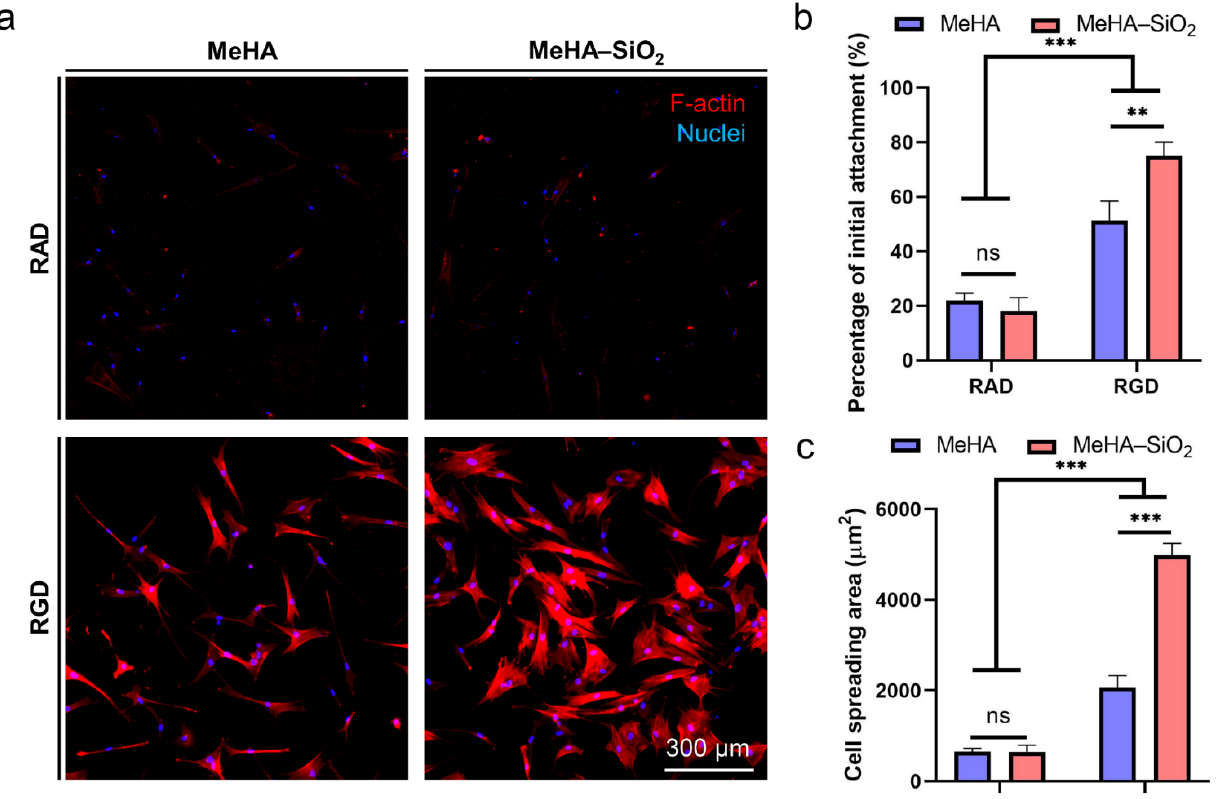
Figure 3. Microscopic observation of hMSC adhesive behaviours on soft nanocomposite hydrogel. ( a ) Cytoskeletal staining (F-actin, red) with nuclei (blue) staining of cells cultured on MeHA and MeHA–SiO 2 hydrogels for 24 h. RAD replaces RGD as a control group. Statistical quantification of ( b ) the percentage of initial cell attachment (24 h) and ( c ) cell spreading area. The error bars represent the s.e.m. ns represents statistically not significant and significance difference p -value: ** p < 0.001; *** p < 0.001 (one-way ANOVA).